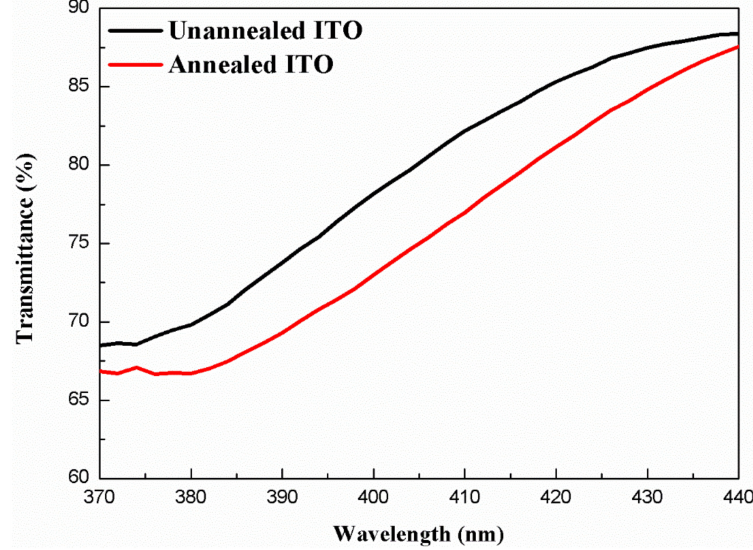
Figure 5. Transmission spectra of the unannealed ITO and annealed ITO films in the wavelength range of 370–440 nm.